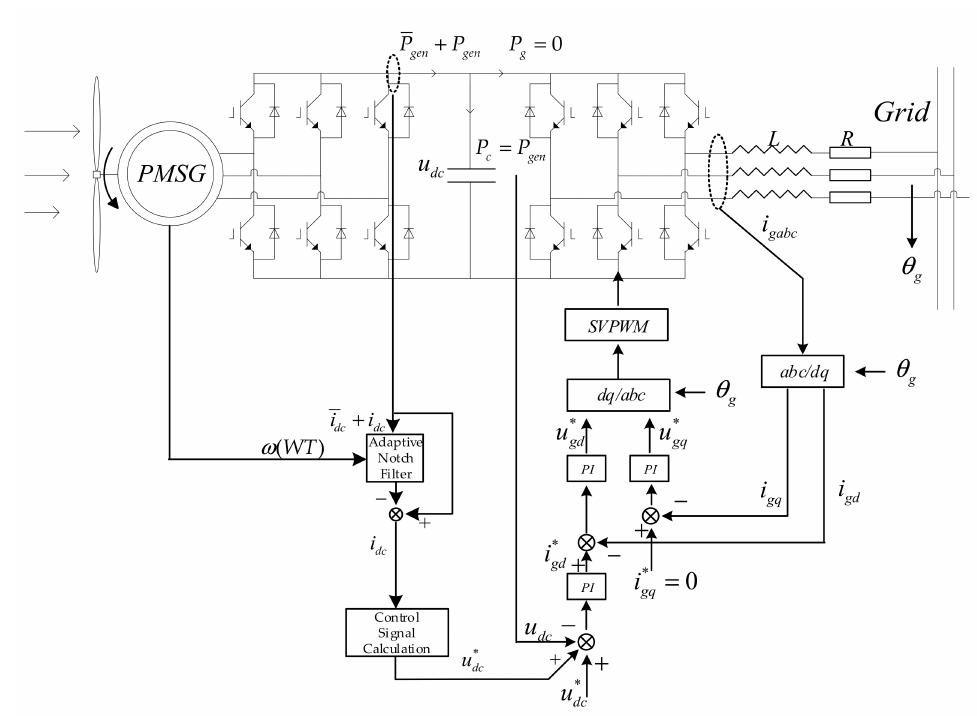
Figure 7. Ripple power suppression method based on current extracting by adaptive notch filter.